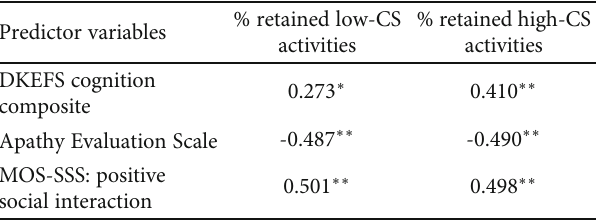
Table 4: Percent retained participation by aphasia status. Table 5: Pearson correlations of potential predictors with Activity Card Sort outcomes for high-cognitive skill and low-cognitive skill activities.